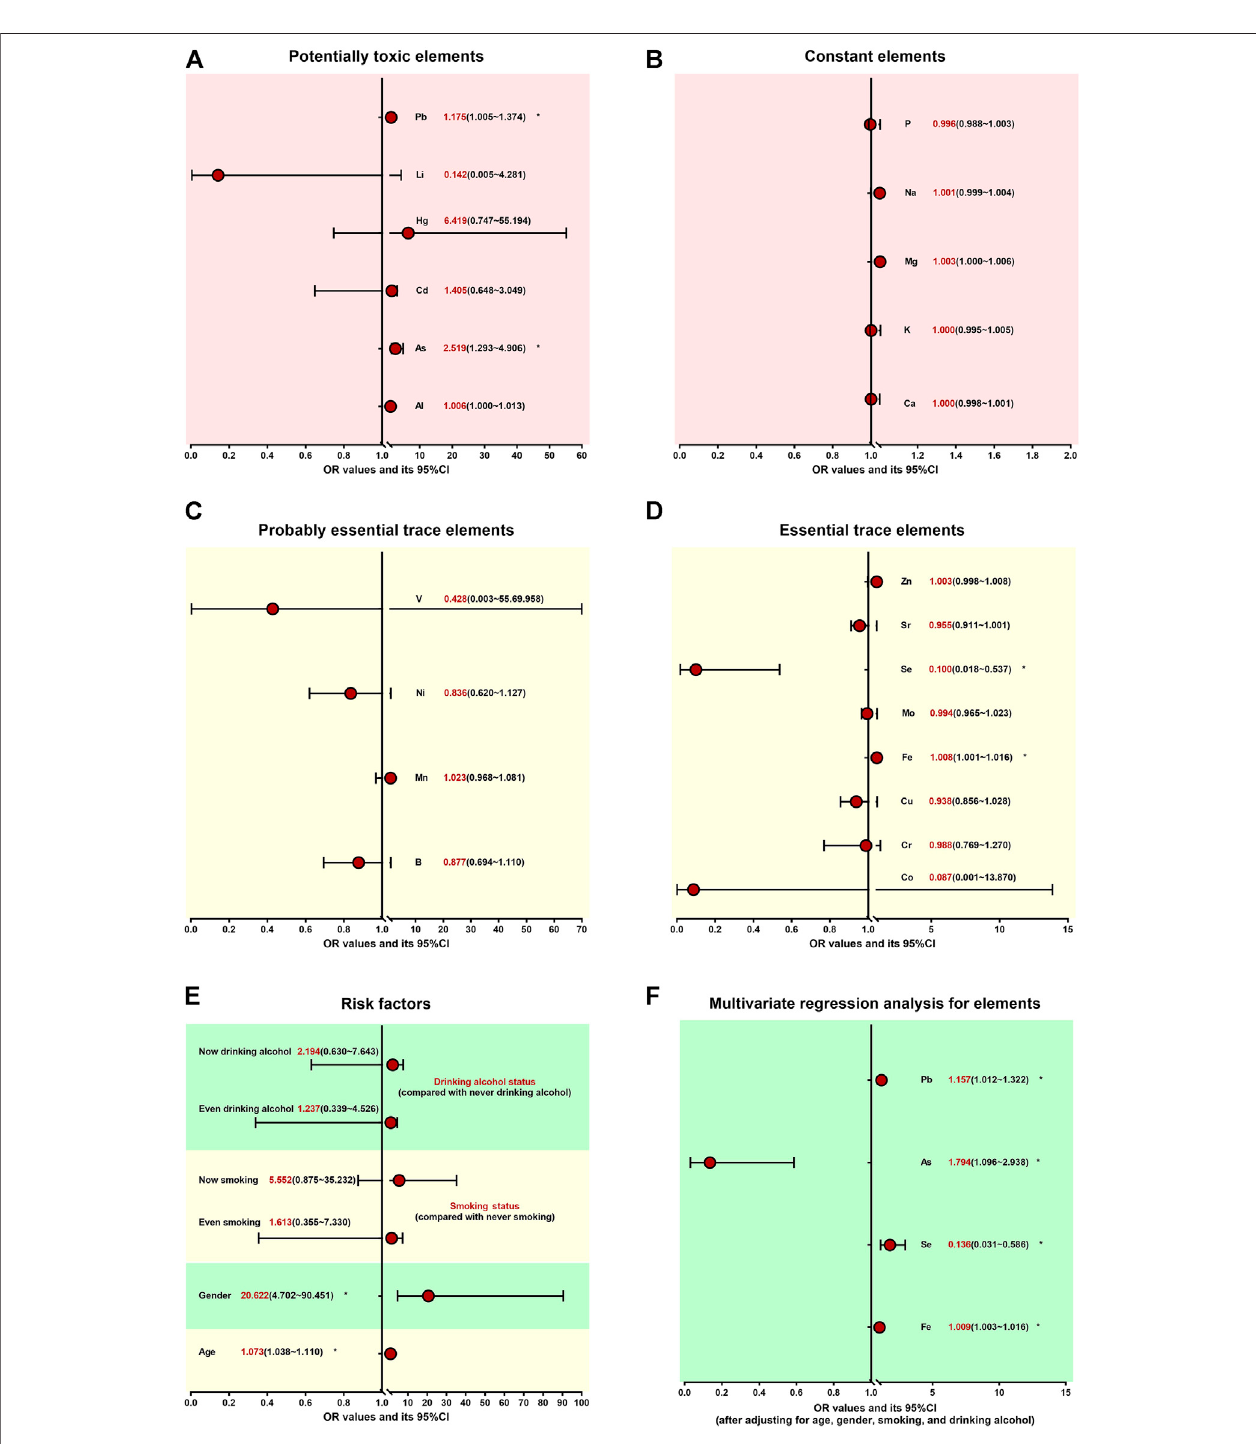
FIGURE 2 | Association and risk between the element ’ s disorder and arsenism * p < 0.05. The univariate logistic regression analysis (A – E) shows the association and risk between the potentially toxic elements, constant elements, probably essential trace elements, essential trace elements, other factors, and arsenism, respectively. After adjusting for age, gender, smoking status, and drinking alcohol status, further multivariate logistic regression analysis results between the element ’ s disorder and arsenism are clearly shown (F) .